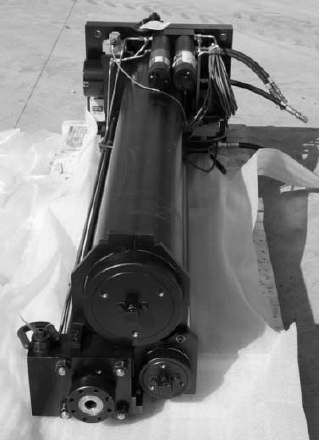
Fig. 3. Blast generator